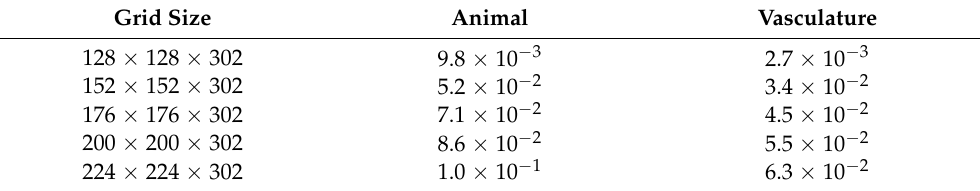
Table 2. FNO super resolution